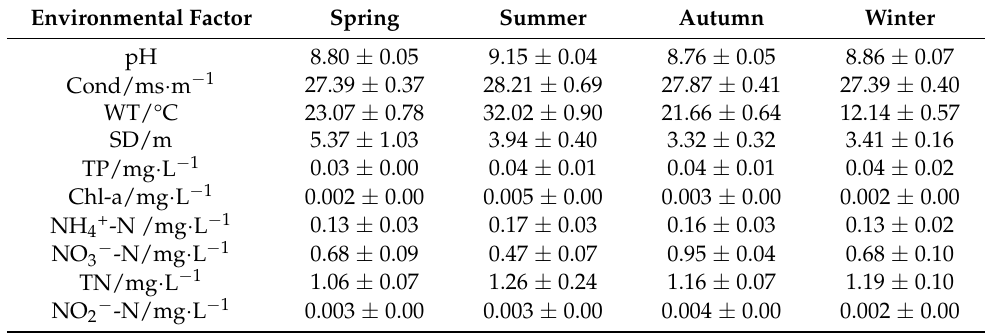
Table 1. Analysis of environmental factors in four seasons in Danjiangkou